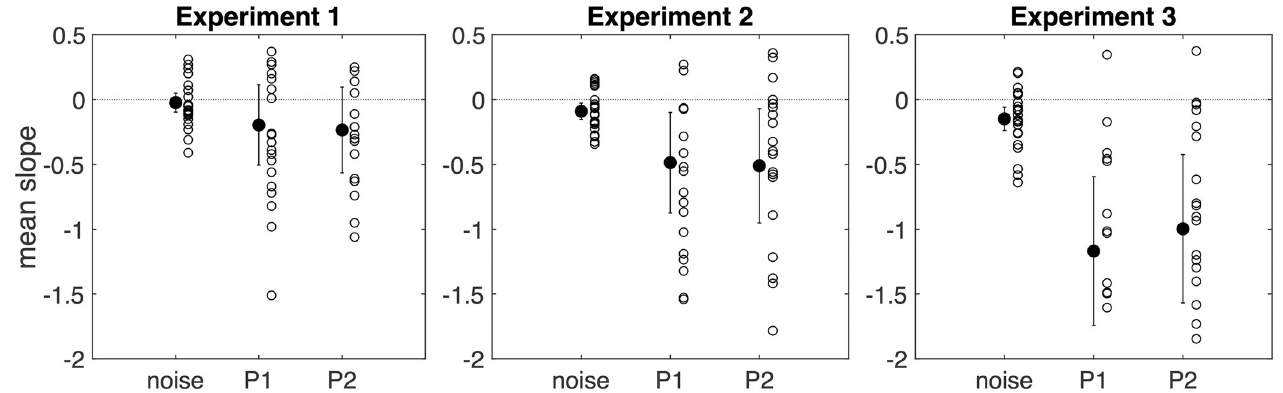
Fig 2. Mean slopes for the three conditions (Noise, Position 1, Position 2) in Experiment 1 to 3. Note . Mean (filled circle) and individual learning slope per Condition (Noise, Position 1, Position 2) for Experiment 1, Experiment 2 and Experiment 3. Error bars represent 95% confidence intervals.